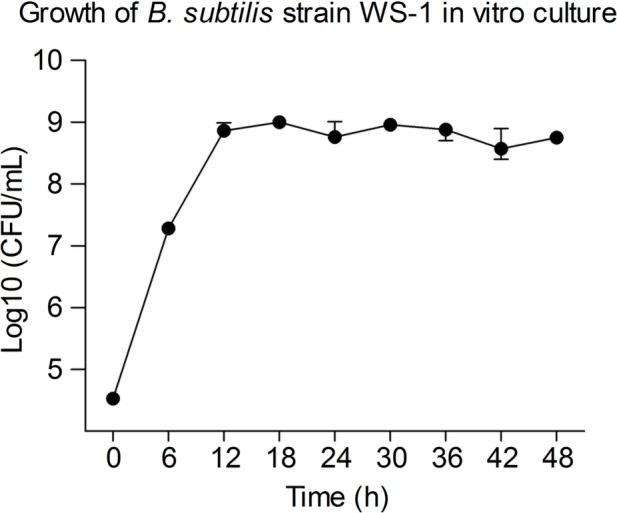
Measurement of bacterial growth. The growth curves of B. subtilis strain WS-1. Bacteria were grown in bouillon fluid medium at 37°C for 48 h with agitation, and the Colony Forming Unit (CFU) was determined at 0, 6, 12, 18, 24, 30, 36, 42, and 48 h. The data are representative of three independent experiments. Data are represented as mean ± SD, n = 3.